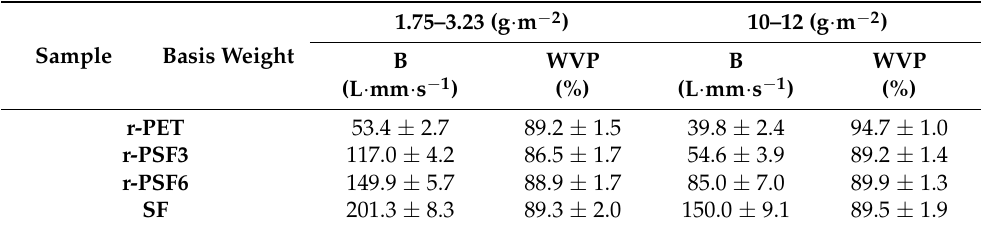
Table 7. Results of air permeability (B) and water vapor permeability (WVP). The values are listed in the form mean ± SD (standard